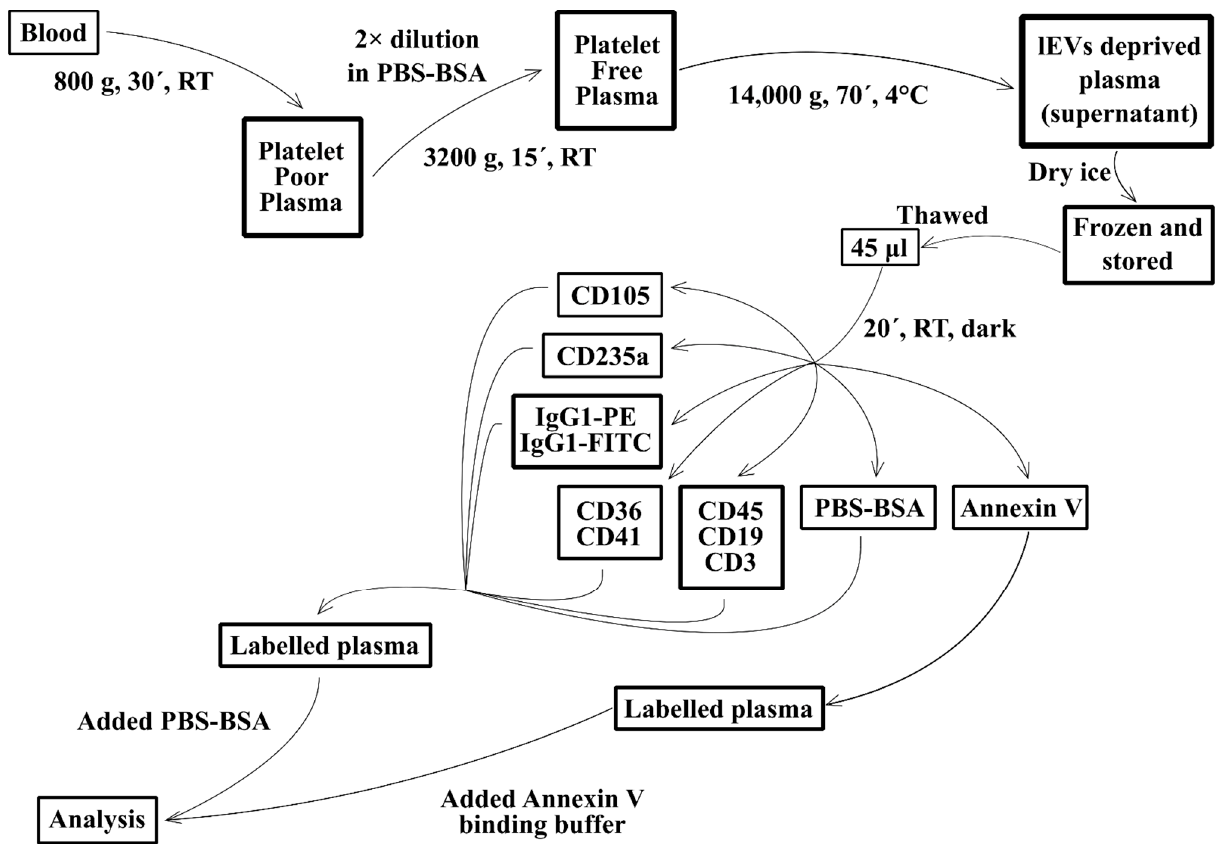
Figure 2. Scheme of preparation and labelling of plasma deprived of lEVs by centrifugation. Each time one patient and one healthy control plasma sample were processed simultaneously. RT—room temperature; PBS-BSA—phosphate buffered saline pH 7.4 with 0.1% bovine serum